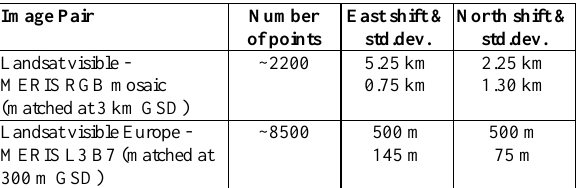
Table 8. 2D global mean shifts and standard deviations between the Landsat Europe visible mosaic, MERIS red band mosaic and MERIS L3 B7 mosaic datasets over Europe.